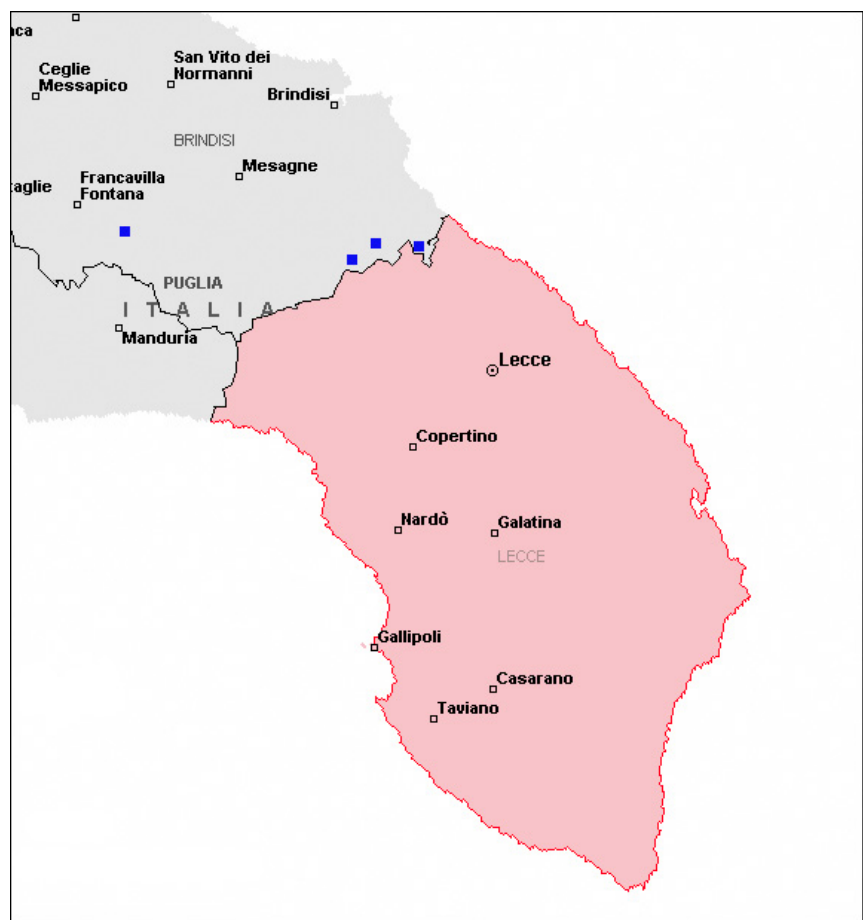
Figure 1. Distribution of Xylella fastidiosa in the Apulia region (Italy). The main outbreak, corresponding to the whole of the Lecce province, is highlighted in pink, while the outbreaks recorded at Oria, S. Pietro Vernotico, Cellino S. Marco and Torchiarolo in the Brindisi province are highlighted in blue. The map was redrawn and adapted from Bollettino Ufficiale della Regione Puglia,